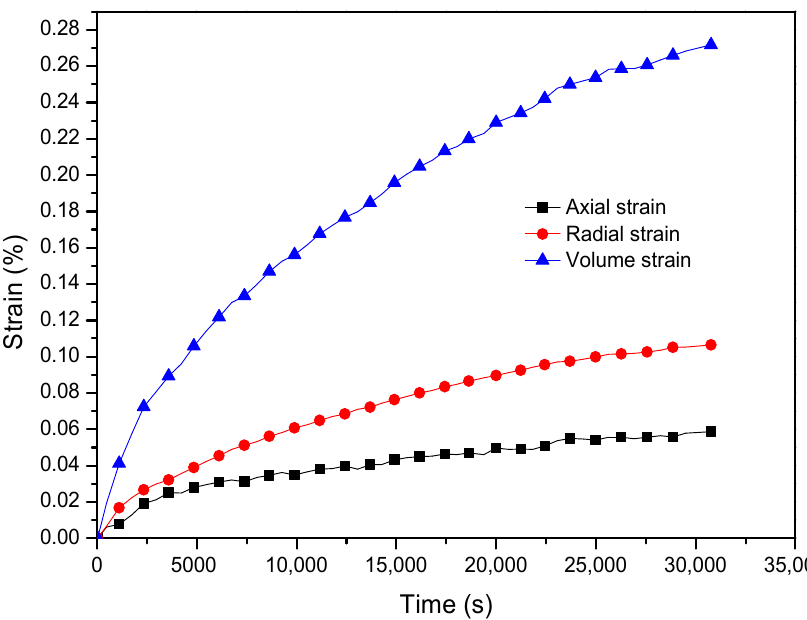
Figure 6. Variation law of CO 2 adsorption strain of loaded raw coal sample with time at 293.15 K.